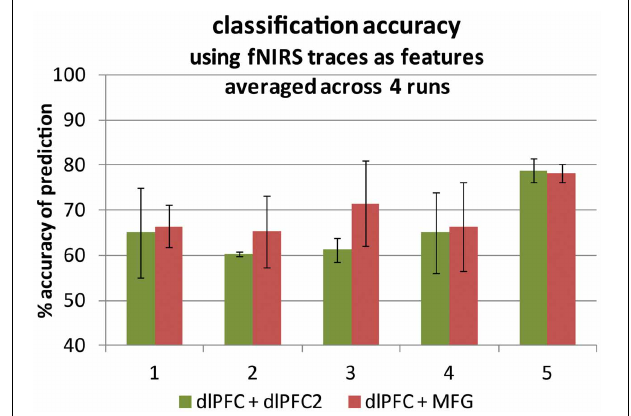
FIGURE 2 | Classification accuracy averaged across four runs for each of five participants. Two fNIRS time traces were used as support vector machine input features in each case. Left-hand bars : within-network pairs (green). Right-hand bars : cross-region pairs (red). Accuracy is the number of time points for which the prediction matched the truth label out of all 2500 time points. An accuracy of 50% represents prediction by chance. Error bars represent ± one standard deviation.